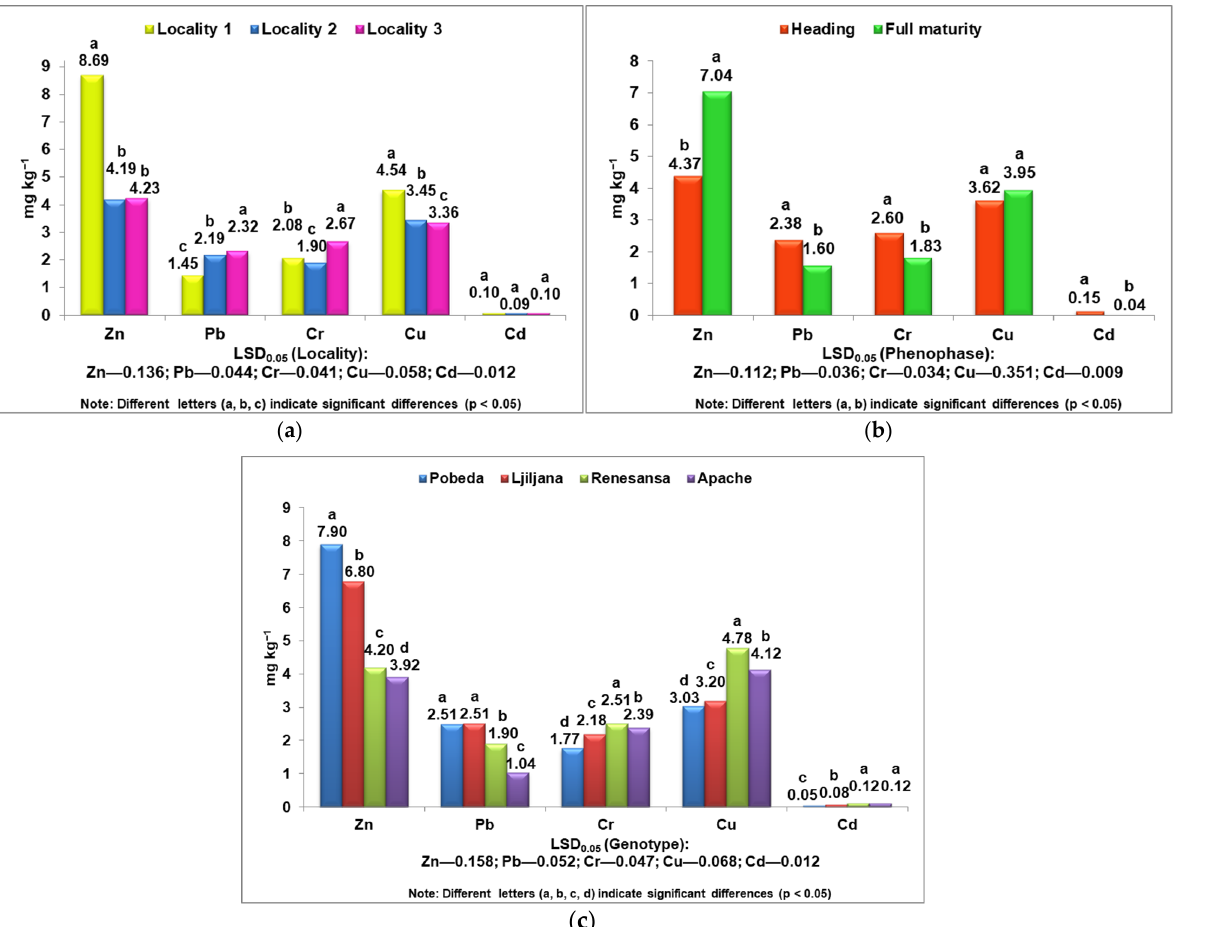
Figure 3. Heavy metal content (mean values, mg kg − 1 ) in wheat roots: ( a ) averaged per localities (average values of four genotypes in two phenophases); ( b ) averaged per phenophases (average values of four genotypes at three localities); ( c ) averaged per genotypes (average values of each genotype at three localities and two phenophases).